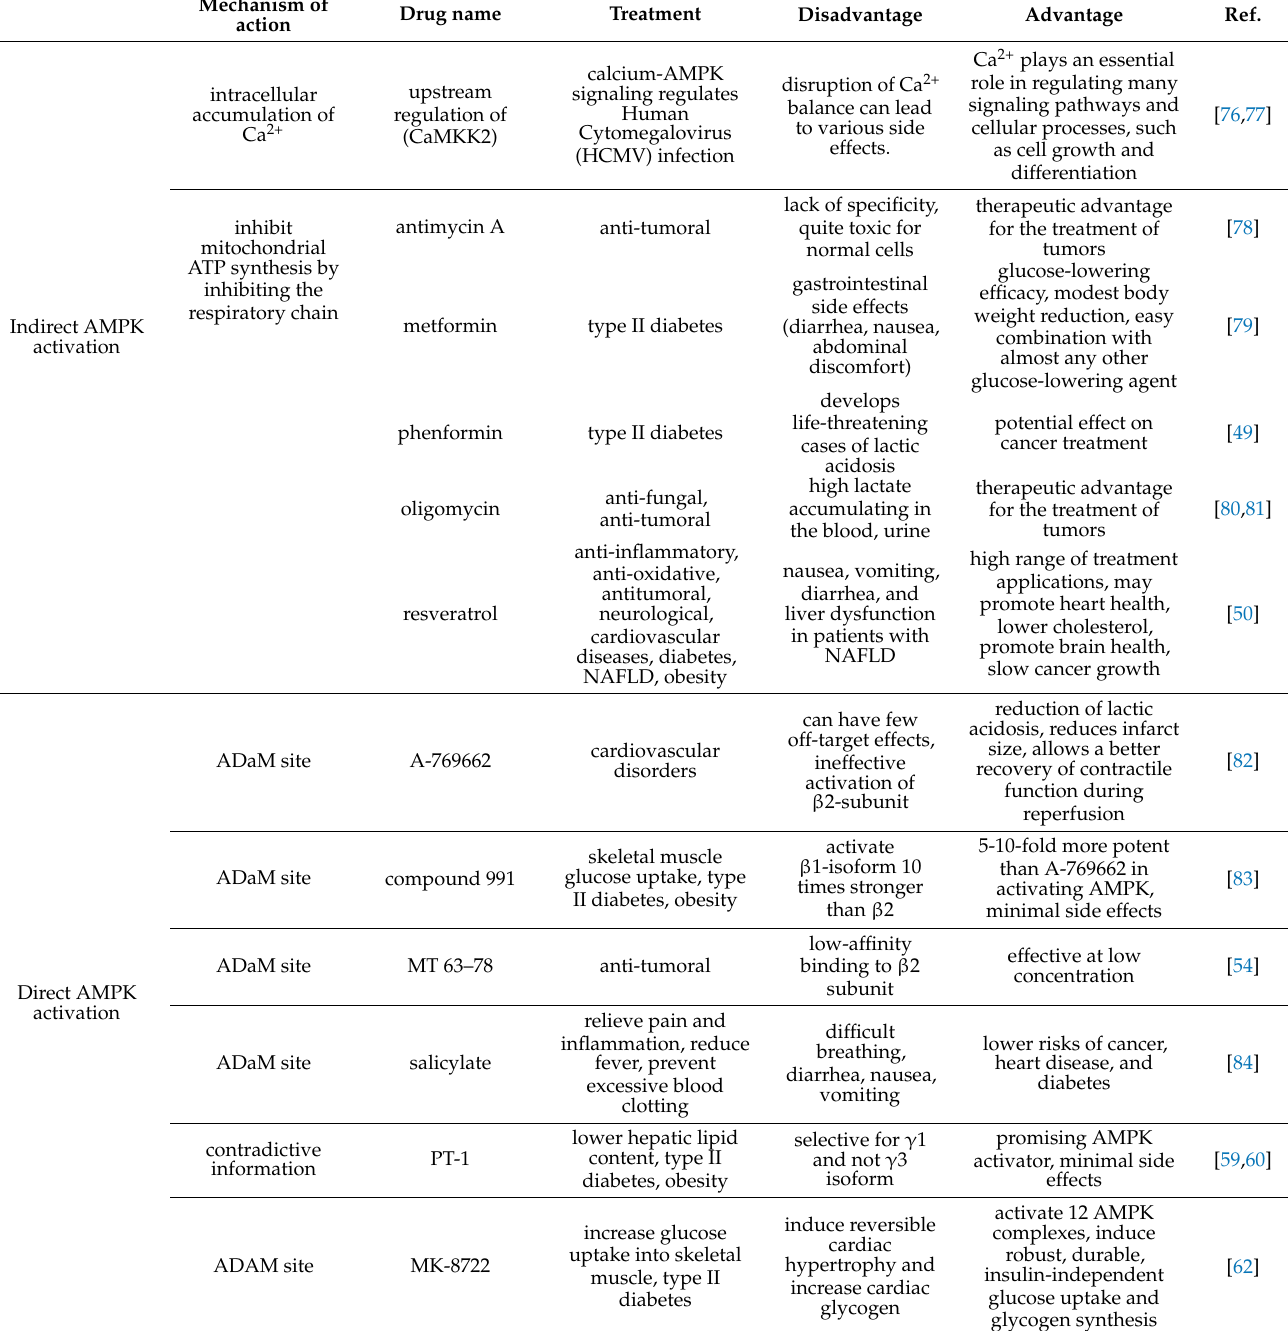
Table 3. Summary and characteristics of AMPK activating